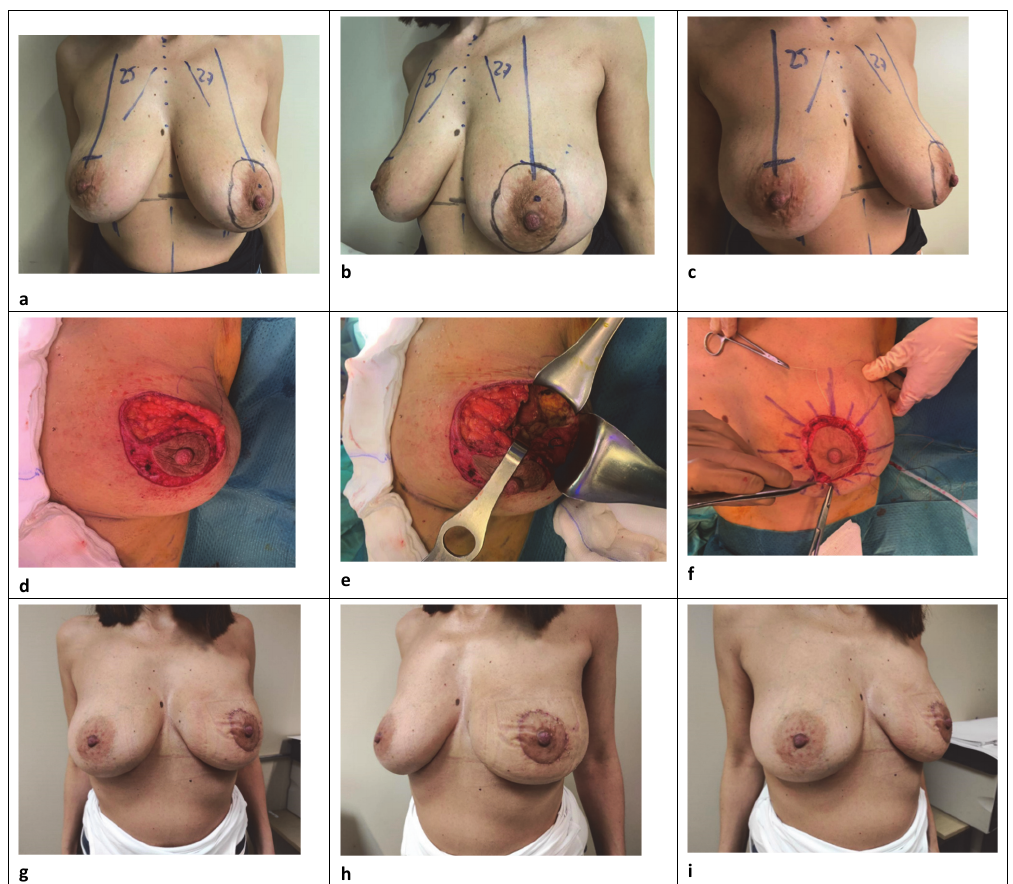
Figure 1. A 46-year-old woman with left multifocal invasive ductal carcinoma (pT1N1, luminal A G1). ( a–c ) Preoperative markings are shown. ( c , d ) Segmental resection of the upper outer on the left using the round block technique. ( e,f ) On table results after closing defects. ( g – i ) One month after surgery, frontal and side view. For the replacement repair, the technique basically employs a transposition flap of skin and subaxillary fat for the breast defect, using the excess of subcutaneous autologous tissue in the lateral extramammary thoracic region (Figure 2) [9]. Its major clinical appli- cation is in patients who refuse higher morbidity procedures or are not candidates for more extensive reconstruction, particularly with myocutaneous flaps. The main indication